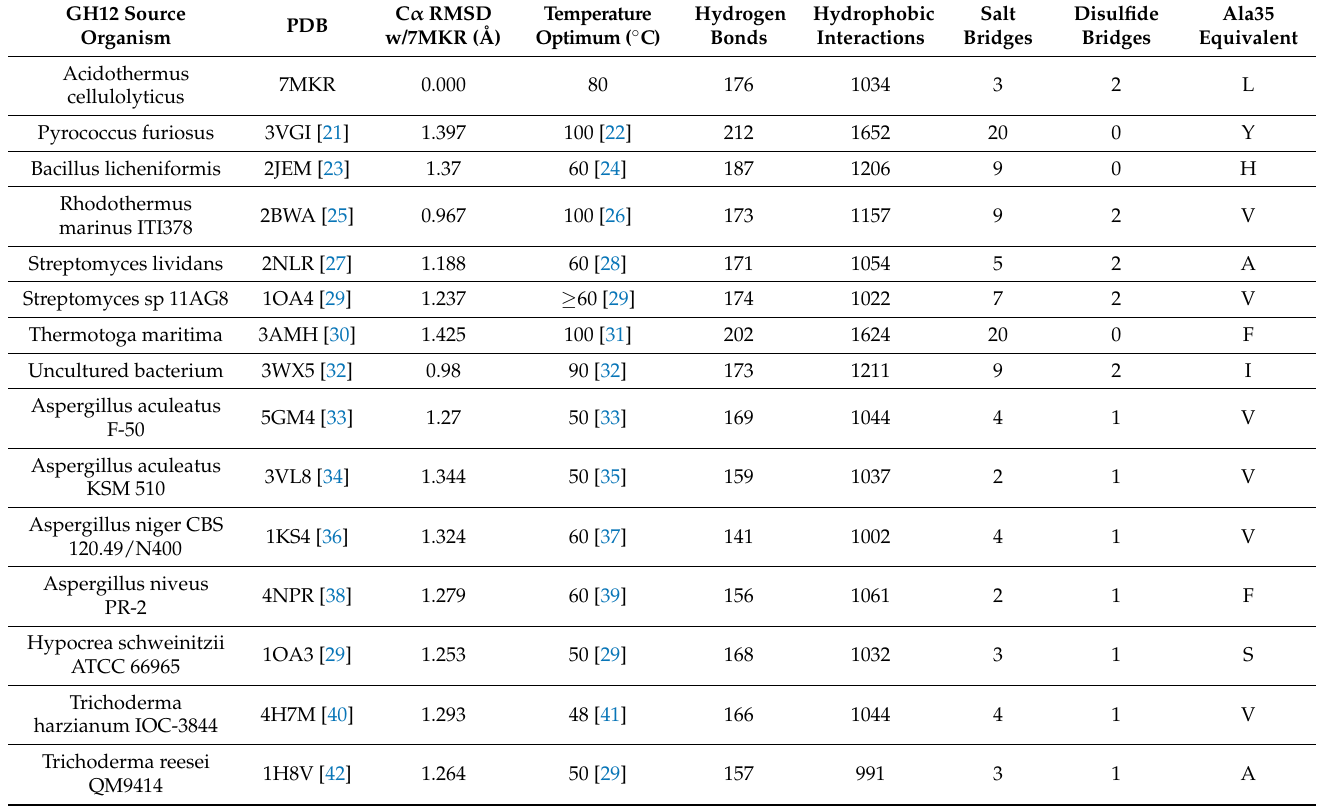
Table 1. Comparison of structural features of GH12s and their temperature optima. Where more than one PDB structure was available, the highest resolution structure with no mutations was chosen. The Ala35 equivalent column refers to the residue that is present at the position corresponding to the T. reesei GH12 alanine